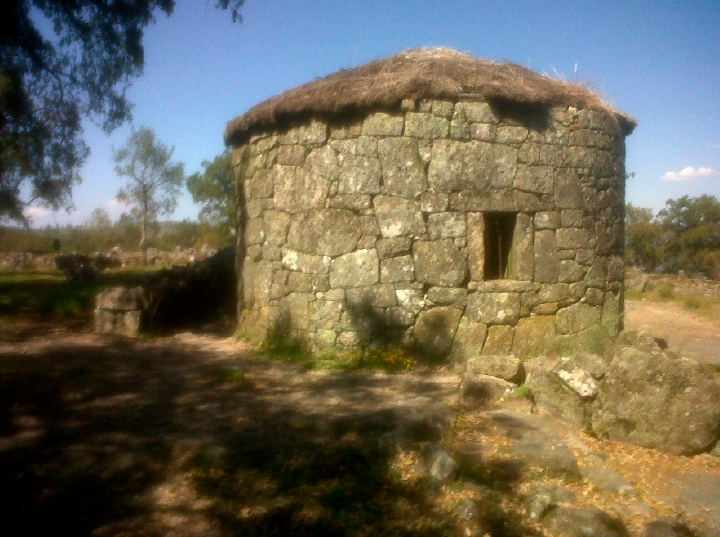
Figure 4. Reconstruction of a house of “Citânia de Briteiros” in Guimarães (Northern Portugal). It is one of the most important settlements of the so-called “Castro culture”, with occupation from the Bronze Age to the Roman period. Upon the arrival of the Romans, the inhabitants of this “castro” and all others in the region were forced to leave the top of the hills and move to the much easier to control valleys. They were likely to have been reoccupied during the short period of the Arab invasion of northern Portugal, and then permanently abandoned.